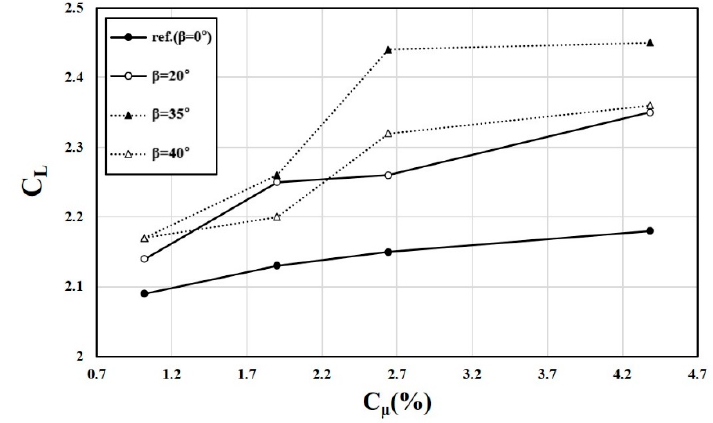
Figure 16. Variations of lift coefficient with momentum coefficient for various bending angles (x 0 /c = 0.7, α = 8°, δ f = 40°).